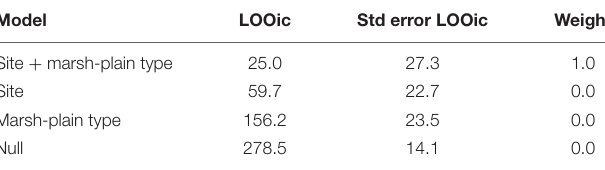
TABLE 3 | LOOic values of each mixing model tested with potential prey as sources for Dicentrarchus labrax